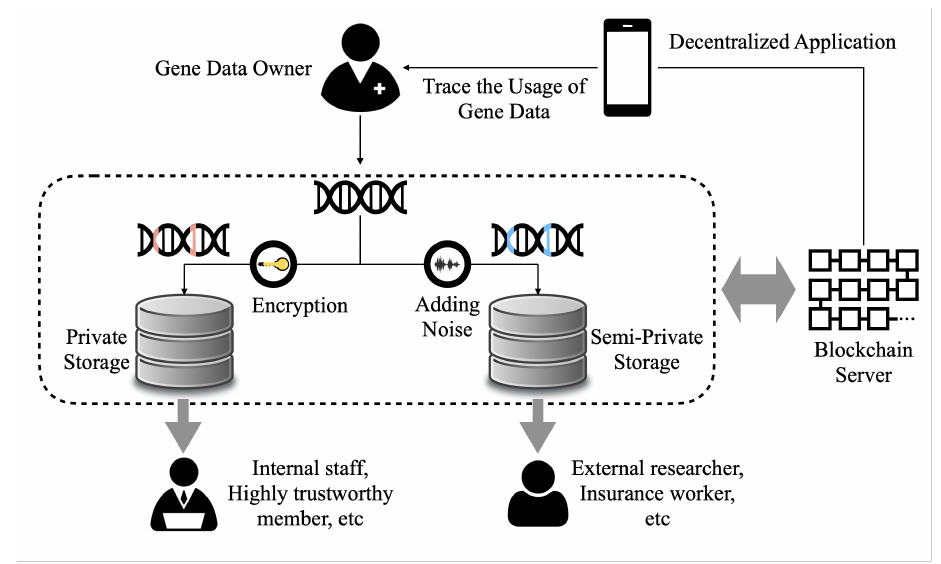
Figure 1. System